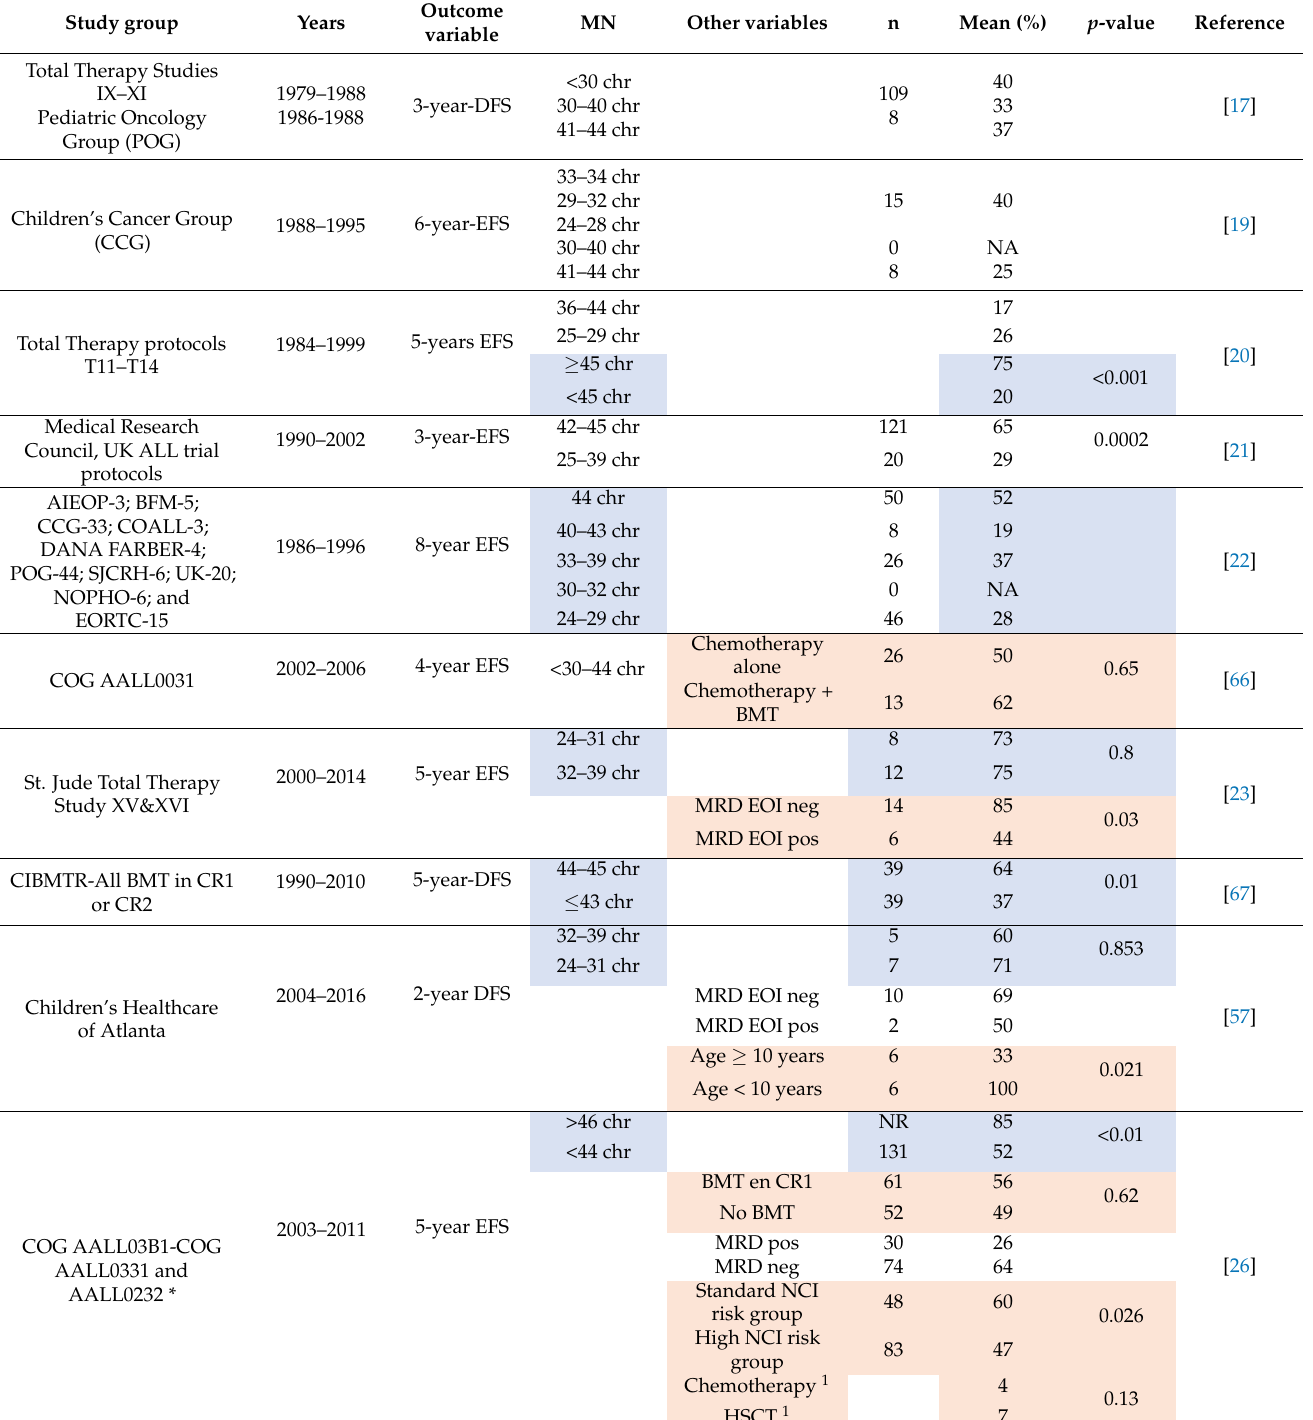
Table 5. Event-free survival reported for patients with hypodiploid B-ALL by several relevant studies. Colored cells indicate statistical comparisons (blue, between chromosome numbers; orange, between other